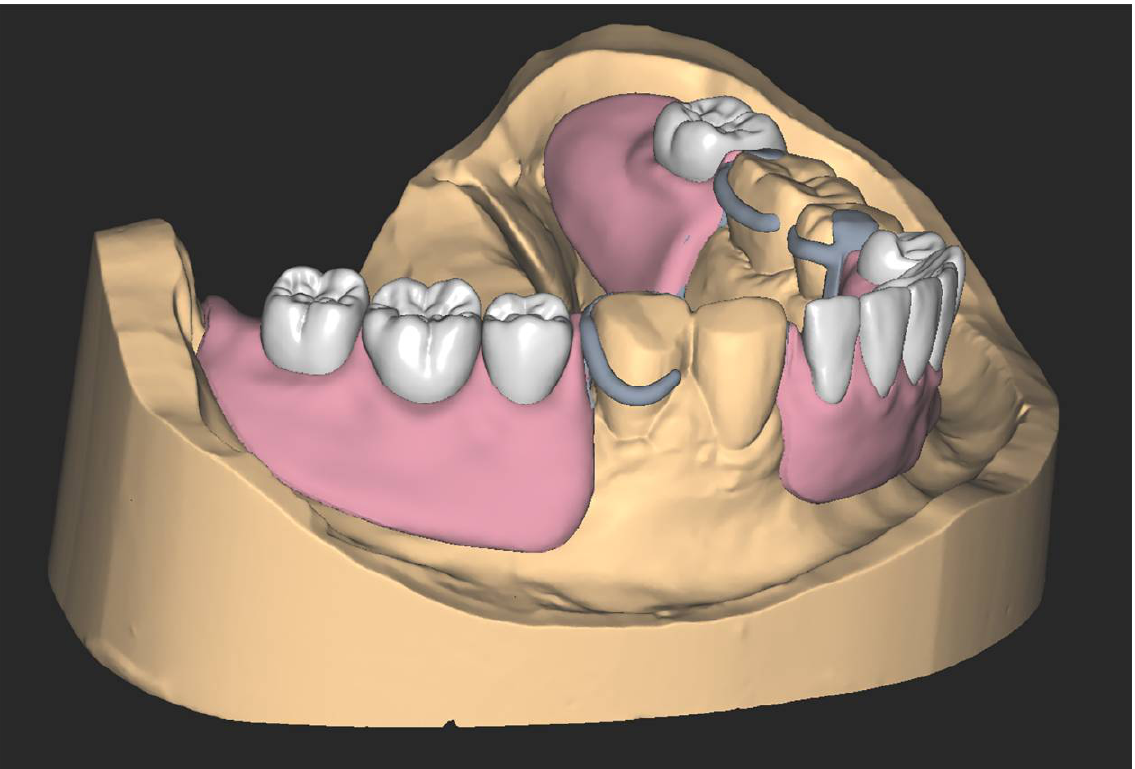
Figure 1. Virtual design of removable partial denture.